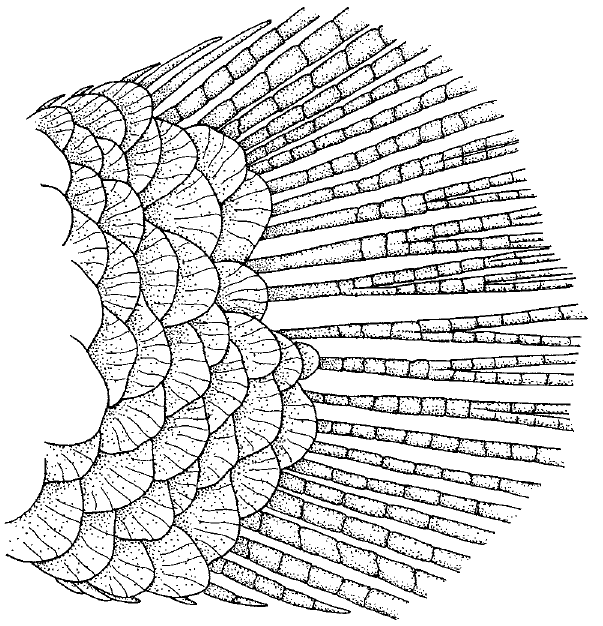
Fig. 14. Knodus sp., MZUSP 38004. Inseminating species. Caudal-fin squamation. Male, SL 34.0 mm, lateral view left side, portraying scales moderately extended out onto caudal- fin rays. Note: lateral line incomplete and not present in re- gion shown. Brazil: Minas Gerais, riacho near Fazenda Poderosa, tributary to ribeirão Jaboticatubas, tributary to rio das Velhas, Campo